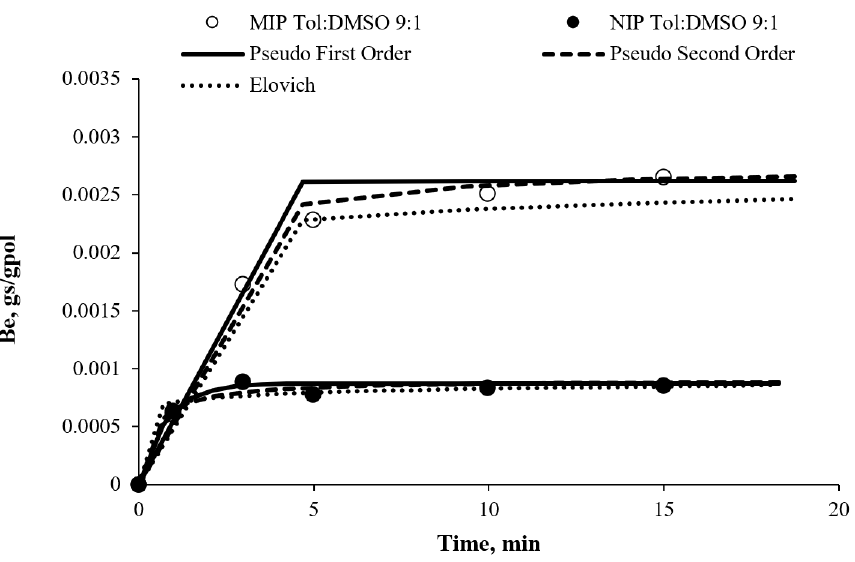
Figure 7. Kinetic evolution of MIP Tol:DMSO 9:1 and NIP Tol:DMSO 9:1 in 20 ppm of Atr concen- tration. Table 7. The parameters of the kinetic adsorption model.